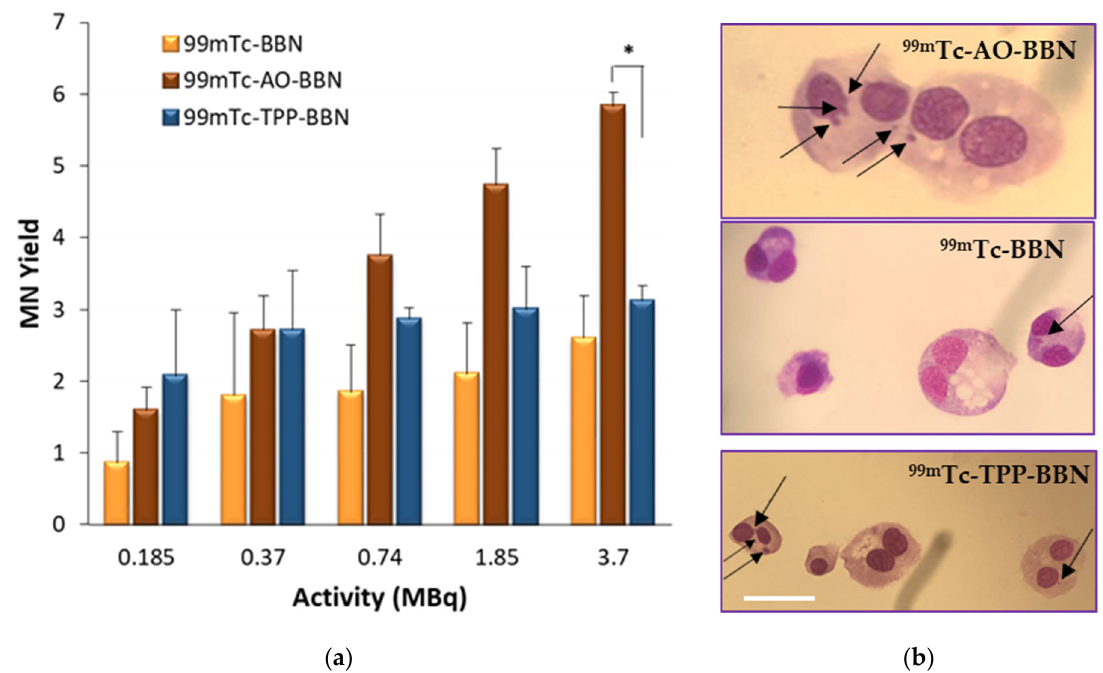
Figure 8. Micronucleus formation in PC3 cells exposed to the HPLC-purified 99m Tc-BBN , 99m Tc-AO- BBN and 99m Tc-TPP-BBN (0.185–3.7 MBq) after 24 h of incubation with the compounds at 37 ° C. ( a ) Activity-dependent MN yield normalized to the control. The data correspond to the mean ± SEM of 3 replicates (* p < 0.05). ( b ) Binucleated cells without and with MN observed at a x43-fold magnification. Scale bar = 35 µm.